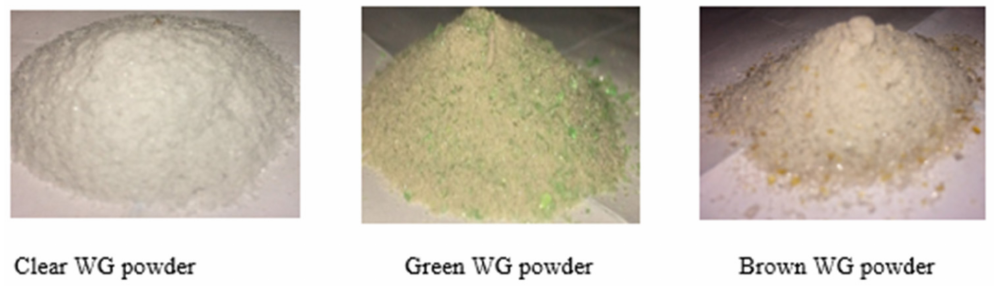
Figure 1. WG powder derived from waste glasses